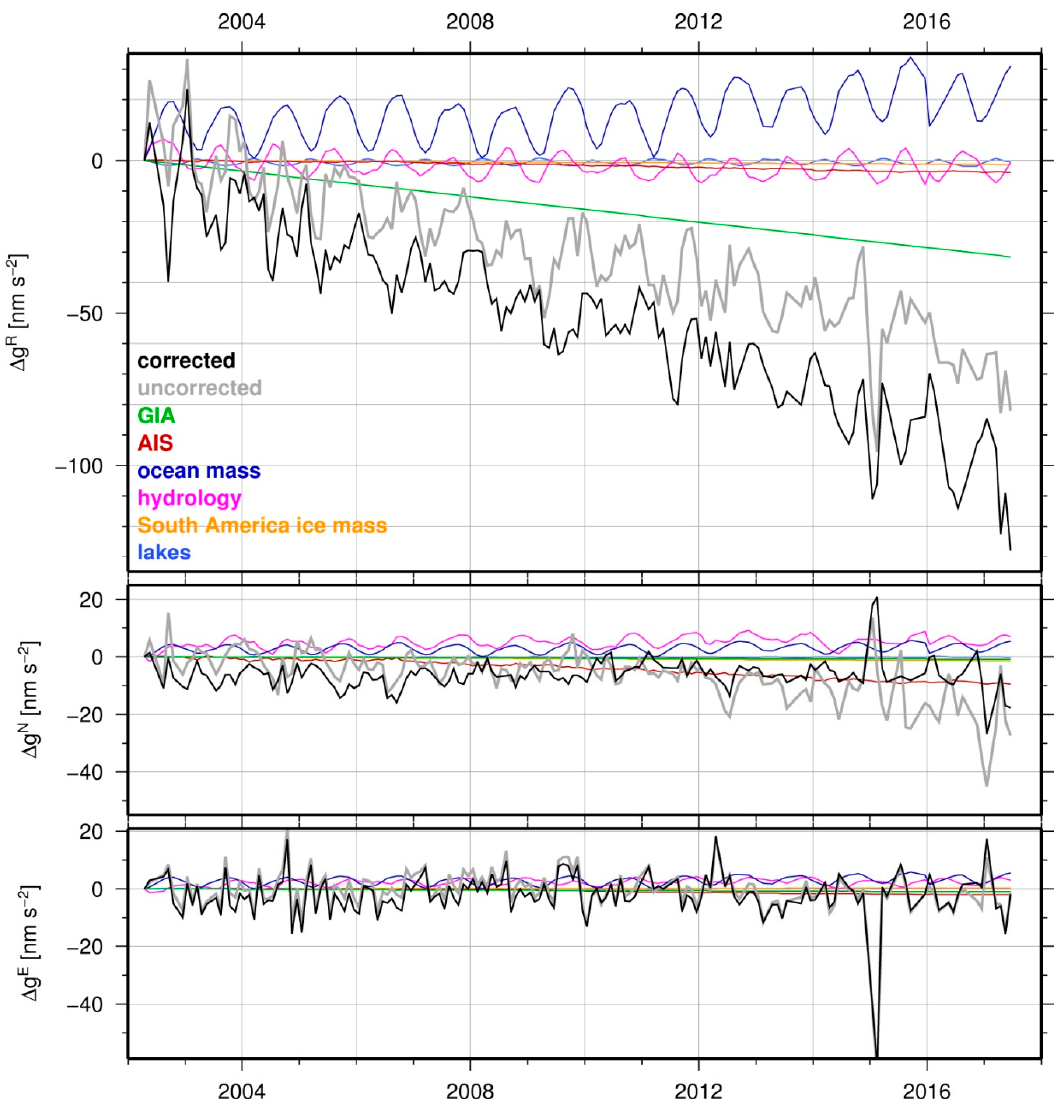
Figure 2. Time series of the gravity signal and the applied corrections for a selected data grid node. The relative change in gravity at the approximate GRACE orbit altitude prior (uncorrected, grey) and after (corrected, black) the application of the corrections described in the text is shown in the radial (top), north (center), and east (bottom) vector components. The applied corrections for the five mass-variation processes are shown in different colors. The location of this grid node is indicated in Figure 1 (yellow circle).